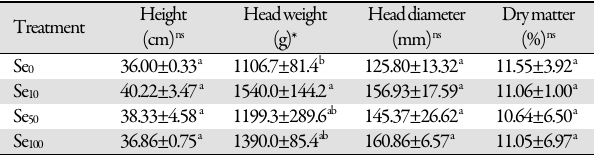
Values represent means ± SD. Figures followed by different letter within a column are significantly different (*: p ≥ 0.90, **: p ≥ 0.95, ns: non-significant).